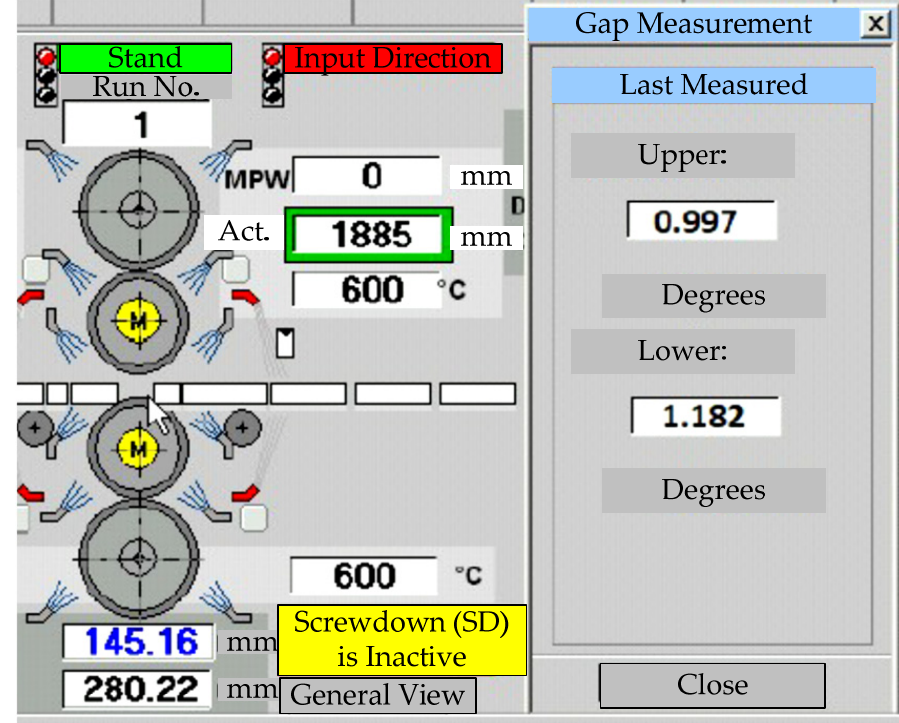
Figure 12. A screen fragment of the Mill 5000 main control station display with the upper and lower spindles calculation results.